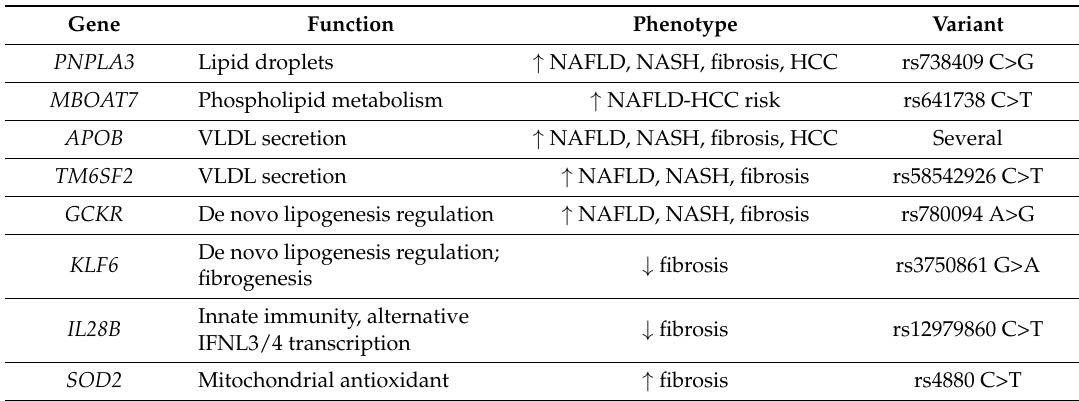
Table 1. Genetic variants (SNPs) associated to NAFLD